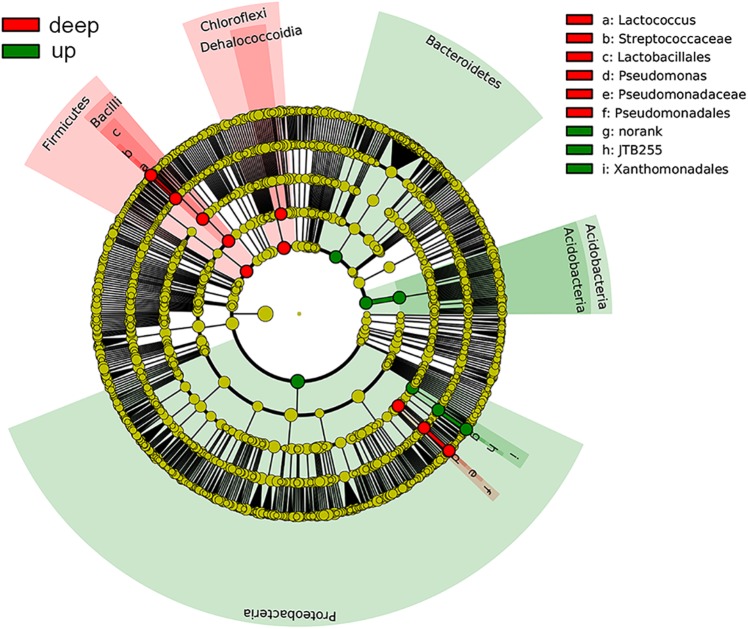
Cladograms showing the differences in relative abundance of bacterial groups between up and deep layers according to the LEfSe analysis with a LDA threshold of 3.5. Taxa with significant differences were highlighted by colored circles and shadings.